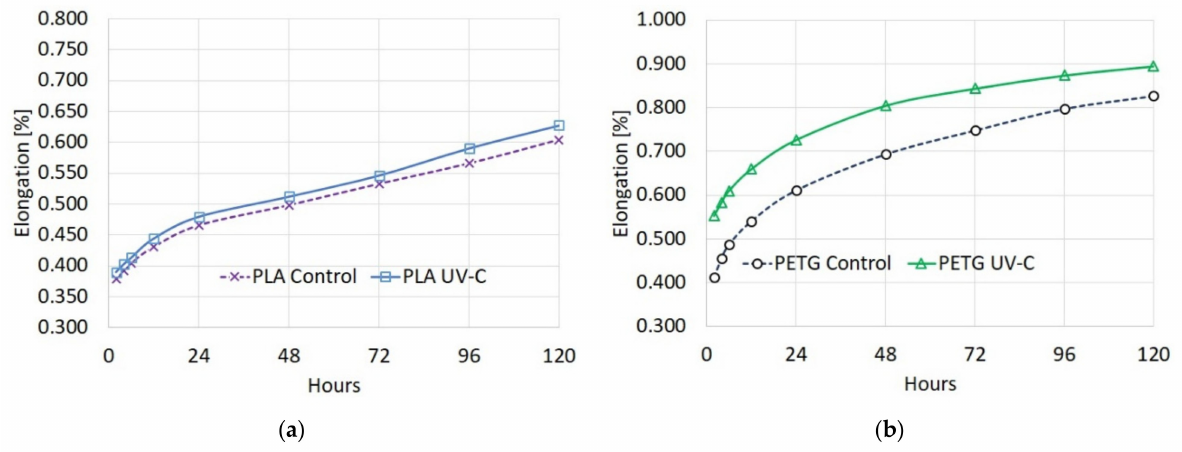
Figure 7. Creep curves of tested materials: ( a ) PLA elongation vs. time; ( b ) PETG elongation vs.